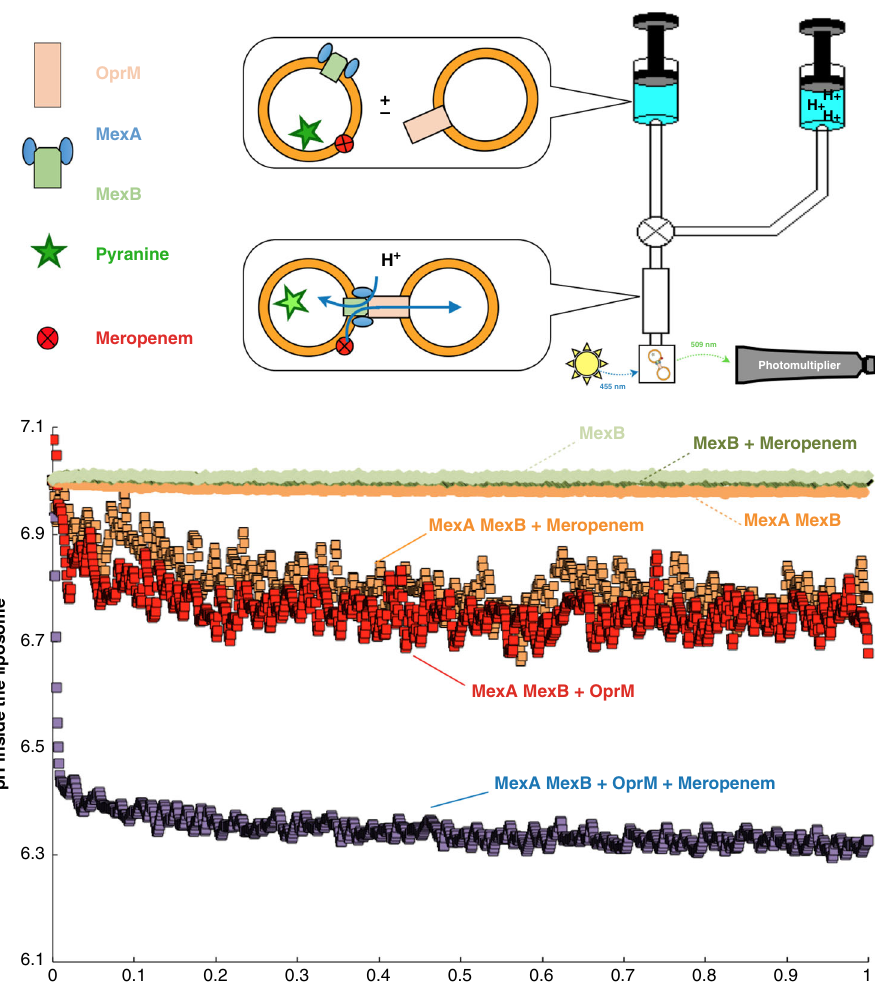
Fig. 1 Transport activity. a Schematic representation of the stopped- fl ow measurement. b Kinetics of acidi fi cation of proteoliposomes in the absence ( “ MexB ” , light green; “ MexA MexB ” , light orange; and “ MexAMexB + OprM ” , red curves) or in the presence of 5 µ M meropenem ( “ MexB ” , dark green; “ MexA MexB ” , orange; and “ MexAMexB + OprM ” , purple curves). The transporter is present under its wild type form in the presence or in the absence of the MexA partner. Proteoliposomes were incubated for 15 min with meropenem and then subjected to rapid mixing with the acidi fi cation buffer (traces are cumulative averages of 5 – 10 measurements for each batch of reconstituted protein). Measurements in the presence of OprM proteoliposomes (red and purple curves) were performed under the same conditions described above, except that OprM proteoliposomes were incubated for at least one hour before the addition